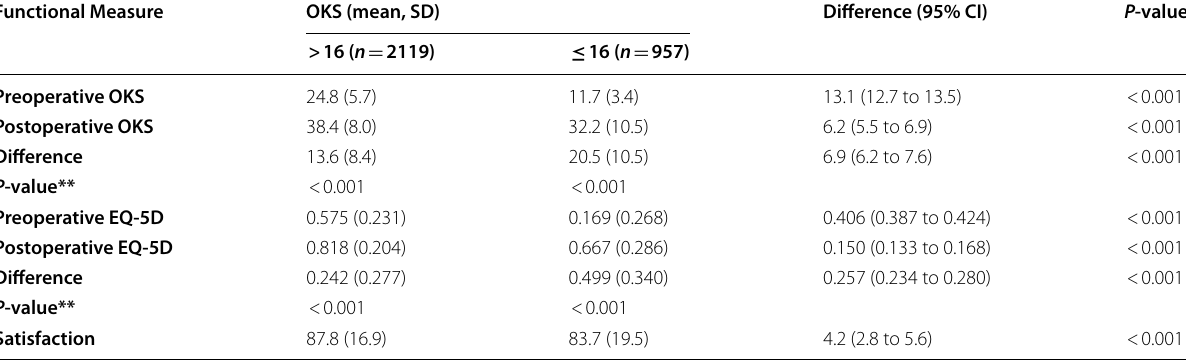
CI Confidence intervals, EQ-5D EuroQol 5-dimension, OKS Oxford Knee Score, SD standard deviation * unpaired t -test ** paired t